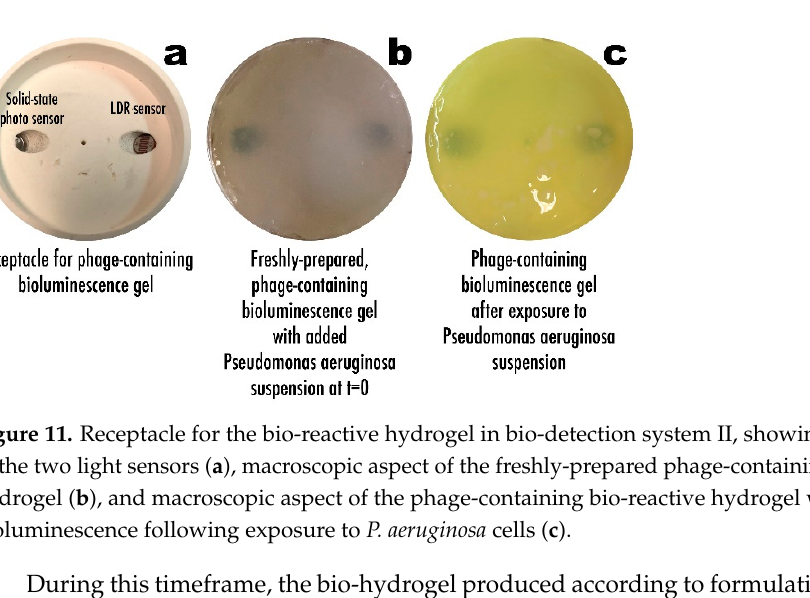
Figure 10. Normalized integrated color density of the optimized bio-reactive chromogel integrat- ing phage particles, sodium 1,2-naftoquinone-4-sulfonate, gelatin, and casein, further added with variable amounts of P. aeruginosa cells, throughout the bioreaction time. Cells of S. aureus CCCD- S009 were used as a control for the bio-detection assays. Values represent the mean of three inde- pendent assays. Error bars represent the standard deviation.